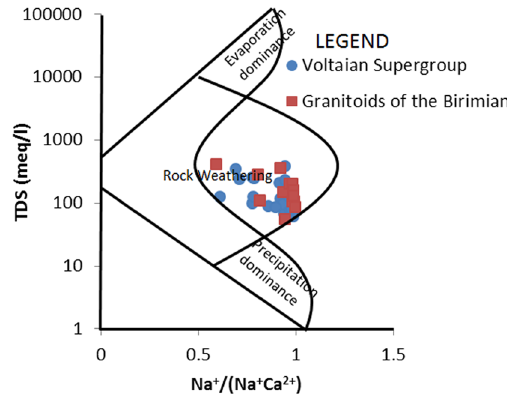
Fig. 6 A plot of TDS versus Na + /(Na + + Ca2 +) of groundwater of the study area